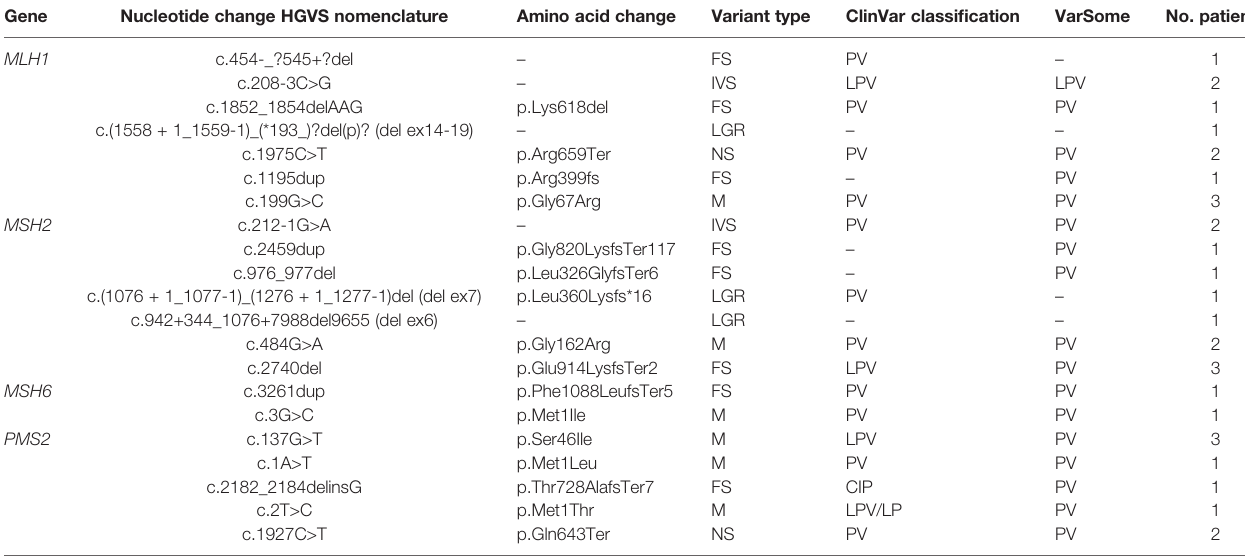
Gene Nucleotide change HGVS nomenclature Amino acid